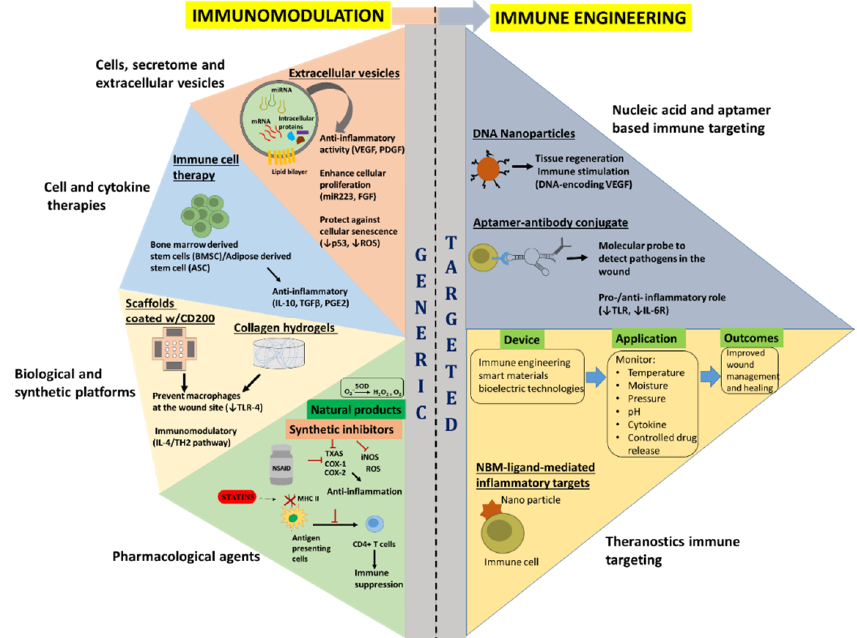
Figure 2. Overview of the current and emerging immunomodulatory (generic) and immune engineering (targeted) approaches for wound healing. Vascular endothelial growth factor (VEGF); Platelet derived growth factor (PDGF); Fibroblast growth factor (FGF); Interleukin (IL)-10; Transforming growth factor β (TGFβ); PGE2; Toll-like receptor 4 (TLR-4); Thromboxane A2 synthase (TXAS); Cyclooxygenases 1 and 2 (COX-1 and COX-2); Inducible nitric oxide synthase (iNOS); Reactive oxygen species (ROS); and Superoxide dismutase (SOD). The red T shaped symbols indicate inhibition or blocking of that particular molecule/process. Table 2. Summary of selected immunomodulatory approaches to promote wound healing.